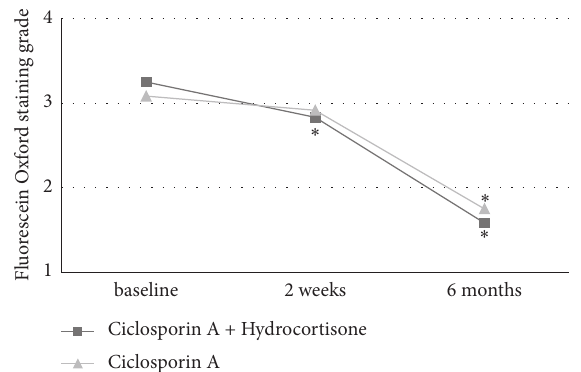
Figure 3: Fluorescein Oxford staining grade in both treatment groups at baseline, after 2weeks, and after 6 months of treatment. Significant differences to baseline are marked with ∗ .